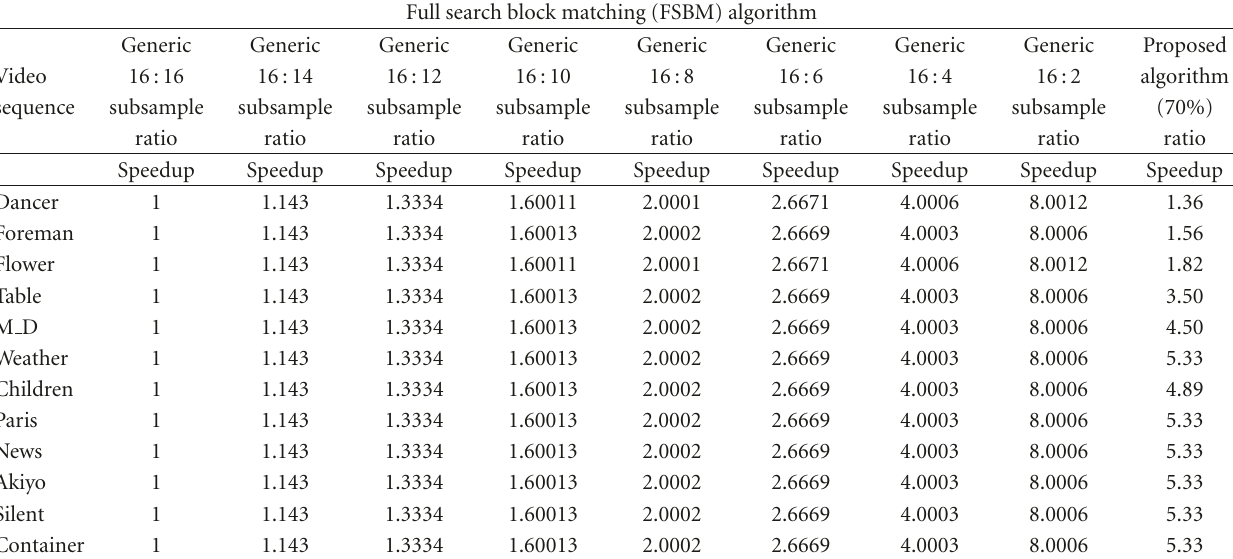
Table 6: Performance analysis of speedup ratio.